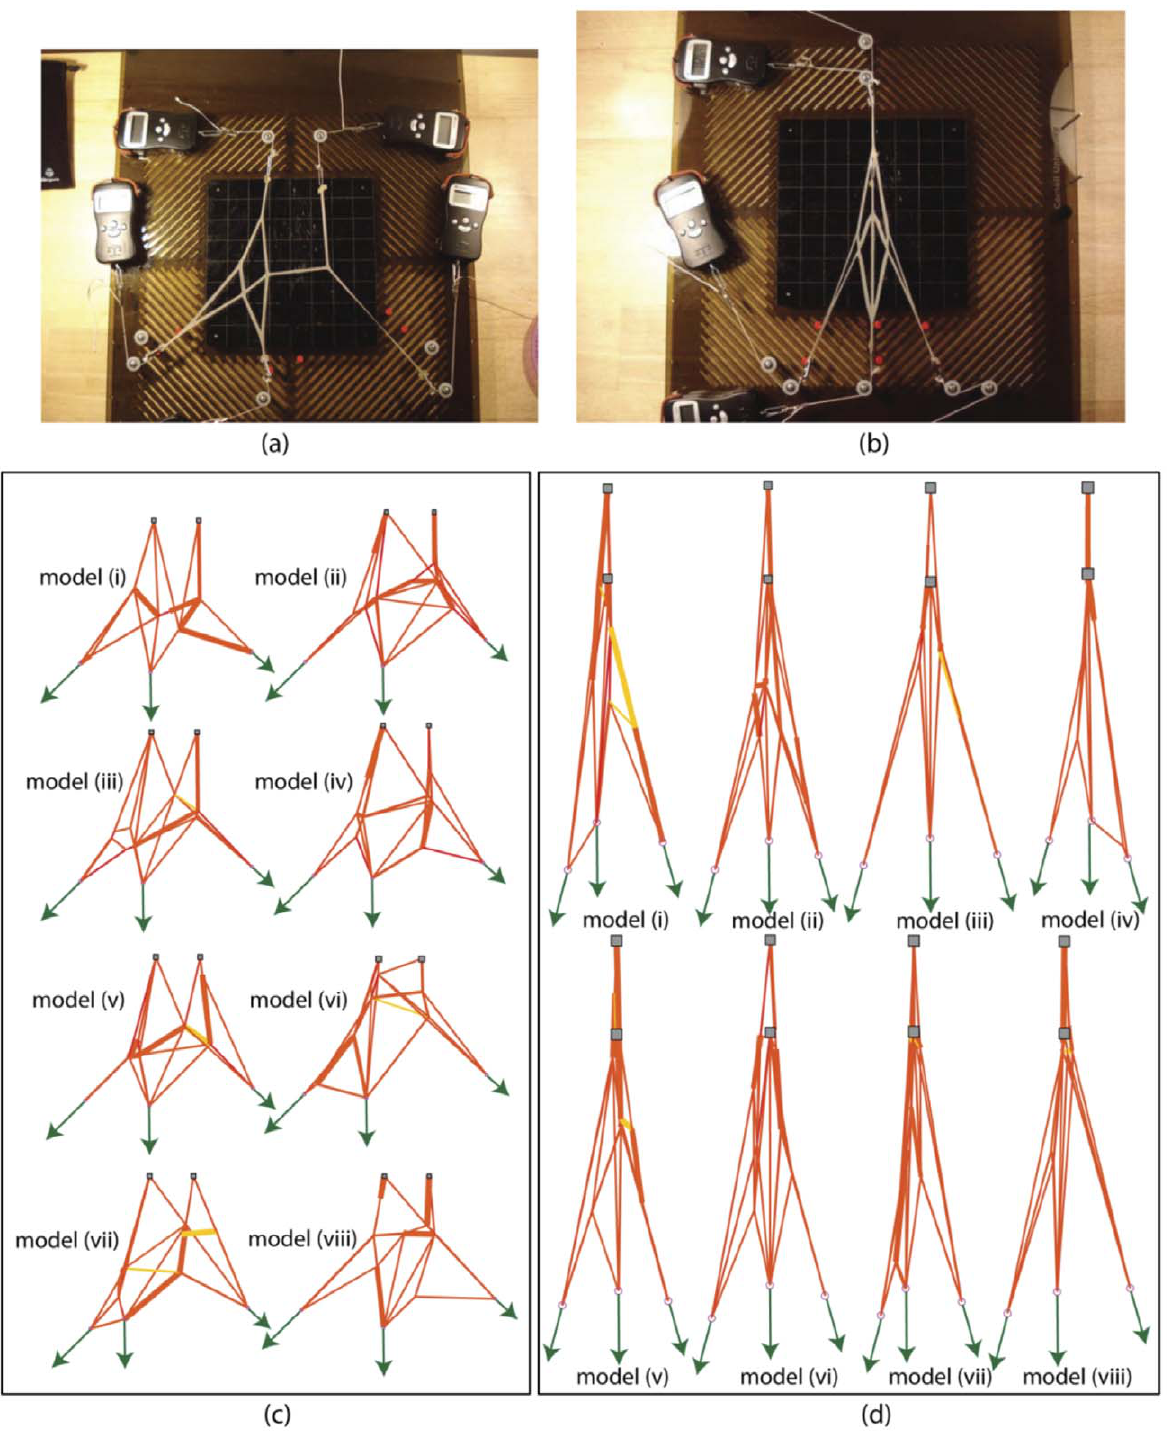
Figure 3. Inference of the synthetic target networks using the informative force-motion data generated from the inference process. The grounded nodes are shown using squares and the actuation forces are depicted using the arrows. Each model is evolved until they see 20 informative experimental data sets. (a) The ‘AFH’ target. (b) adapted Winslow’s Rhombus or ‘aWR’ target. This is an adaptation of the Zancoli’s representation [17] of the finger extensor mechanism (Fig. 4a). In the latter, the diagonal bands and lateral offshoots overlap while in this adaptation, the corresponding strings are fused. The top two grounded ports (through which the reaction forces are measured) are not interconnected. (c) Best eight models evolved through the informative data from the ‘AFH’ target. (d) Best eight models evolved through the informative data from the ‘aWR’ target. Strings colored yellow are slack in the shown equilibrium configuration. Those colored red are taut. Slack strings get taut for some other informative load set that they see during their evolution. Models (iii) in (c) and (ii) in (d) with the least cross validation errors (Table I) resemble in structural constitution with their respective targets.